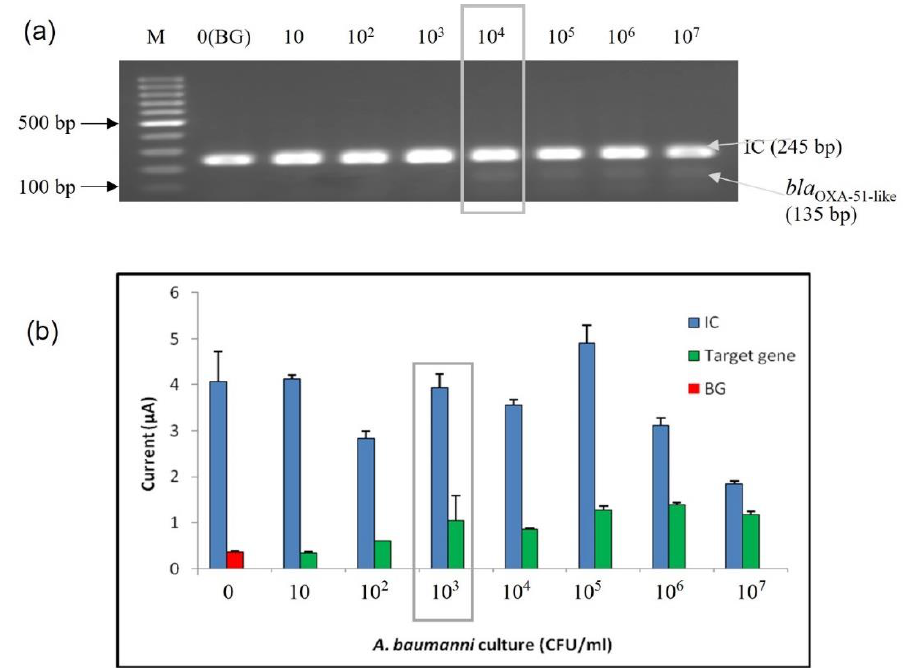
Figure 4. Analytical sensitivity evaluation of the enzyme-based electrochemical DNA biosensor using bacterial lysate from A. baumannii (ATCC 19606). ( a ) Agarose gel analysis; ( b ) enzyme-based DNA assay electrochemical DNA biosensor. The error bars show the standard deviation for triplicate tests. The limit of detection for the agarose gel and enzyme-based DNA assay were highlighted in the gray box. (M: 100 bp DNA ladder; BG: background control).